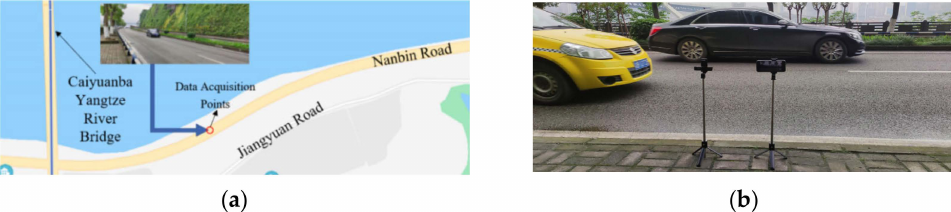
Figure 9. Schematic diagram of data acquisition. ( a ) selection of data acquisition points and ( b ) data acquisition (left bracket: a recording pen, right bracket: a